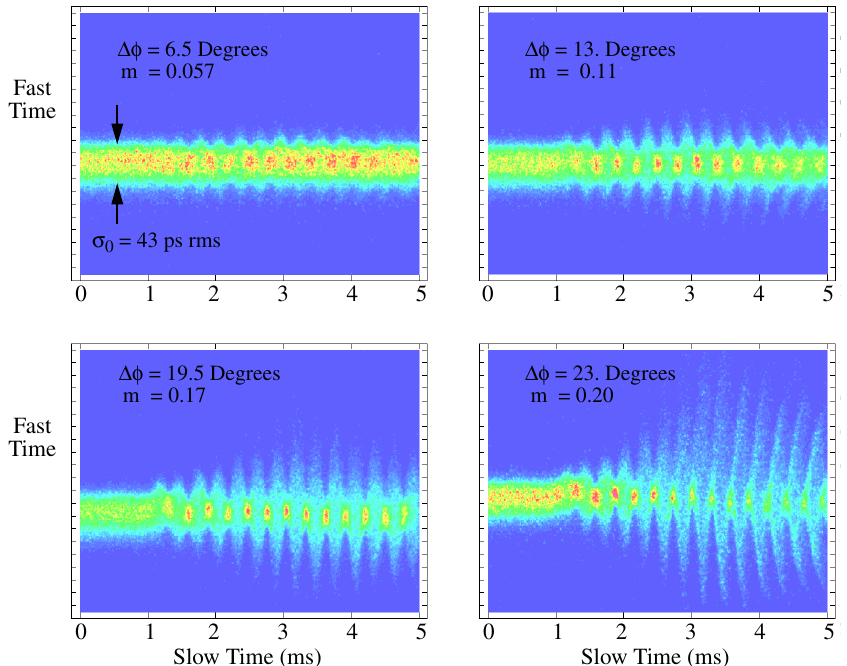
FIG. 14. (Color) Streak camera images showing effect of phase